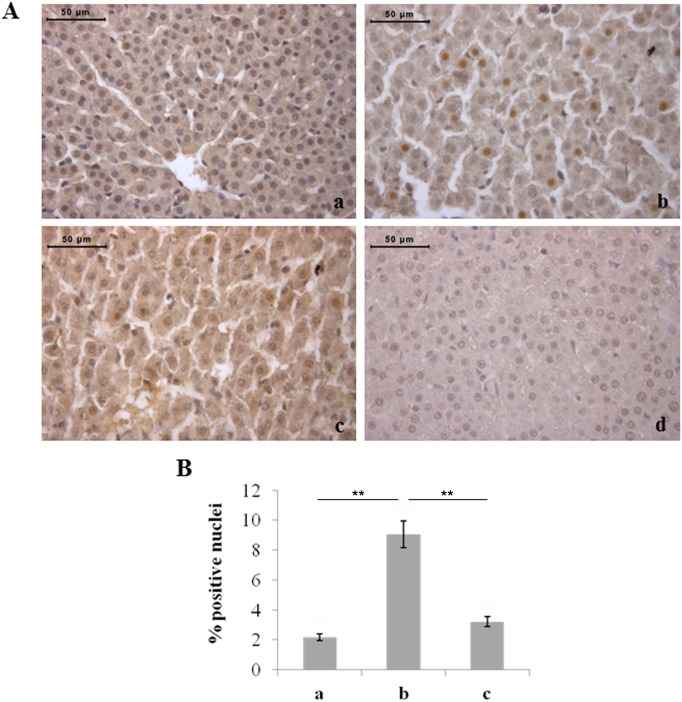
Moderate hyperoxia increases the number of HIF-1α-positive hepatocytes with respect to normoxia and severe hyperoxia.A) Immunohistochemical detection of HIF-1α expression in neonatal rat livers exposed to moderate and severe hyperoxia. a) ambient air; b) 60% hyperoxia; c) 95% hyperoxia; d) negative control; scale bar: 50 µm, magnification 40x. B) Graphic representation of the percentages of HIF-1α positive nuclei (±SD); densitometric analysis determined by direct visual counting of ten fields for each of three slides per sample. ** = p<0.01.